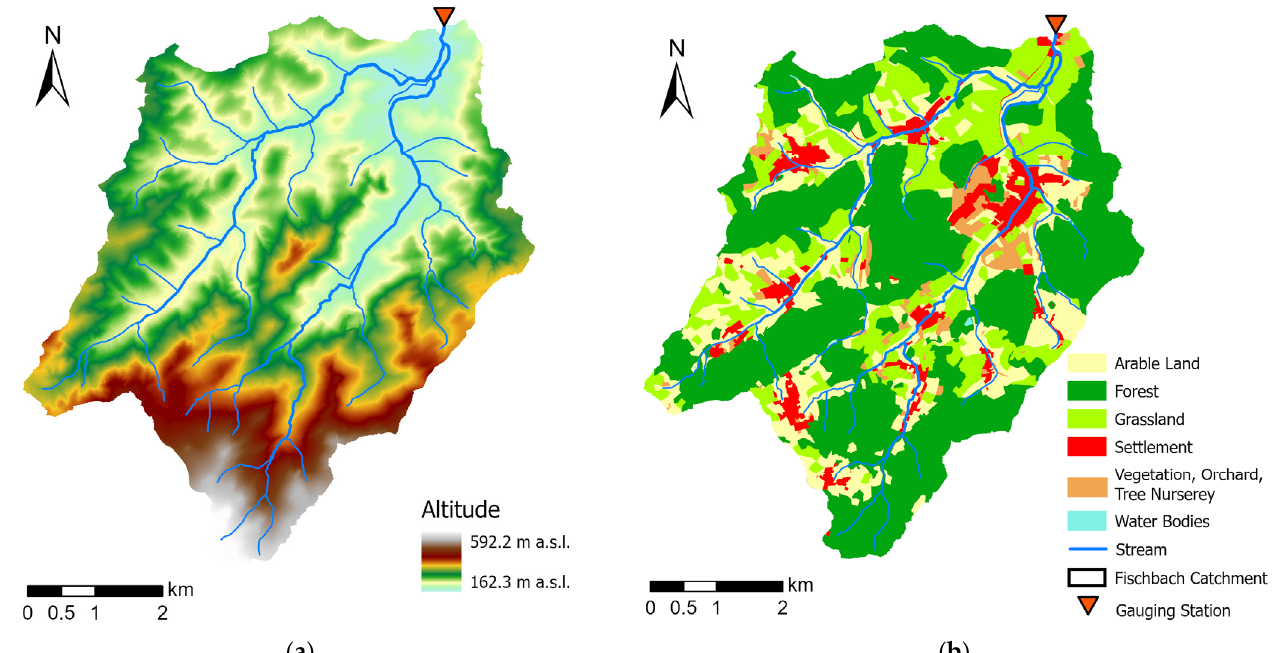
Figure 1. Fischbach catchment: ( a ) Digital elevation model (5 m × 5 m) based on [30]; ( b ) land use based on digital landscape model (DLM) of the official topographic-cartographic information system dataset (ATKIS) [29].